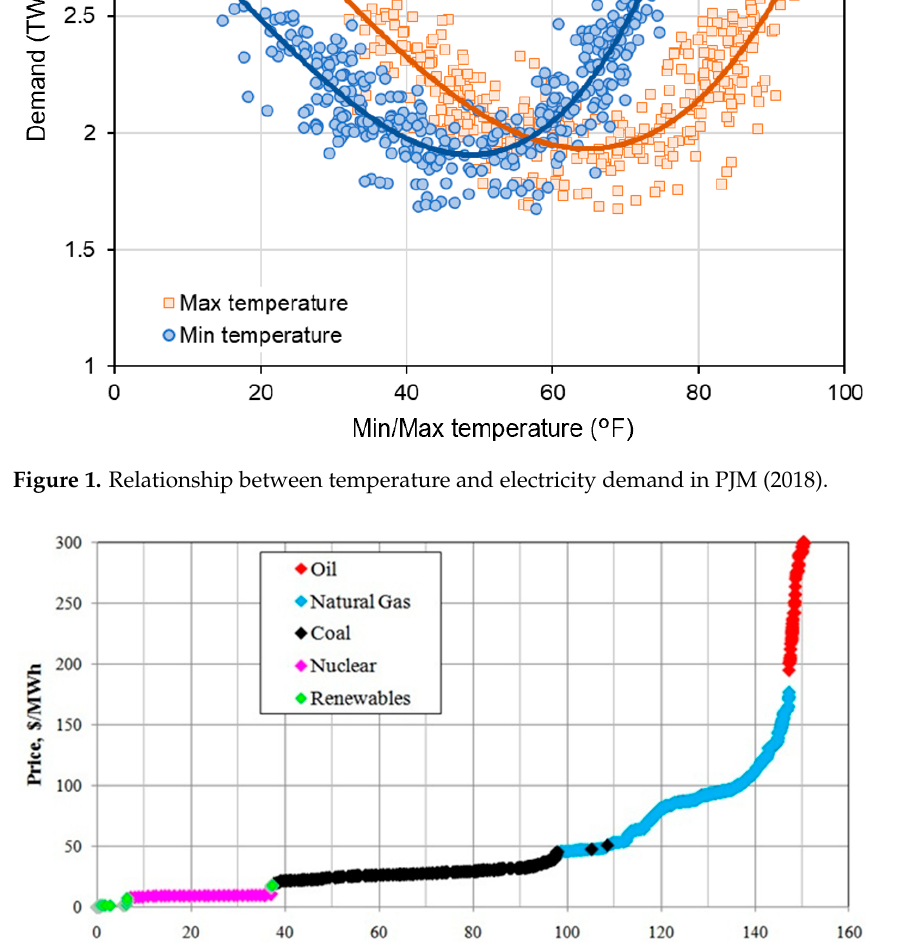
Figure 1. Relationship between temperature and electricity demand in PJM (2018).